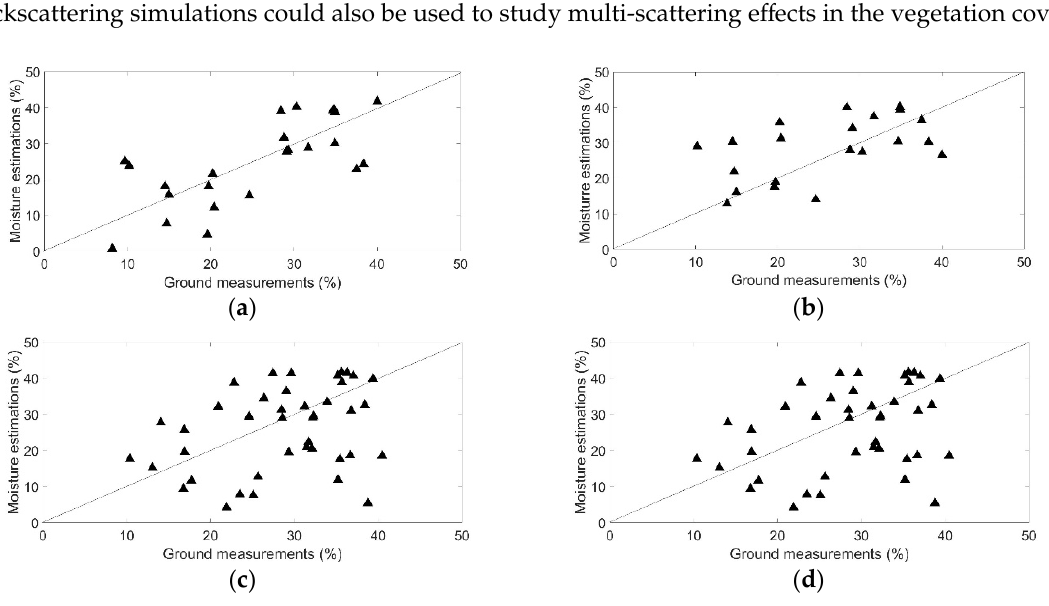
PALSAR radar data, ( a ) turmeric, HH polarization, ( b ) turmeric, HV polarization, ( c ) marigold, HH